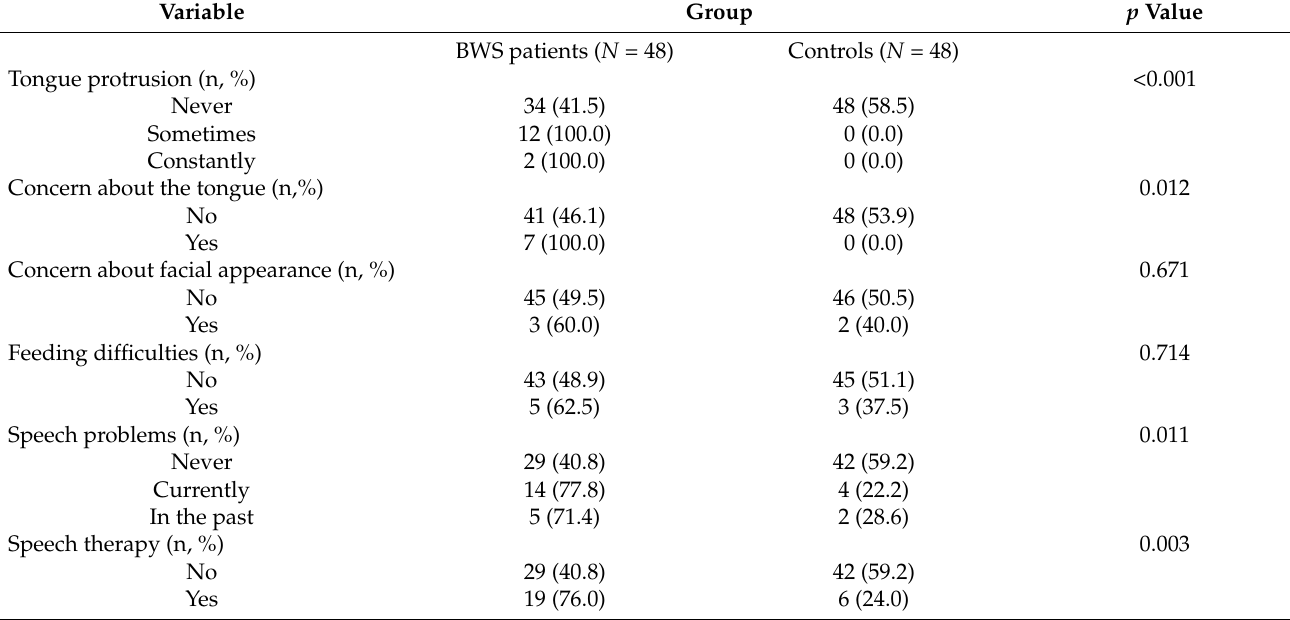
Table 4. Aesthetics, feeding and speech problems by